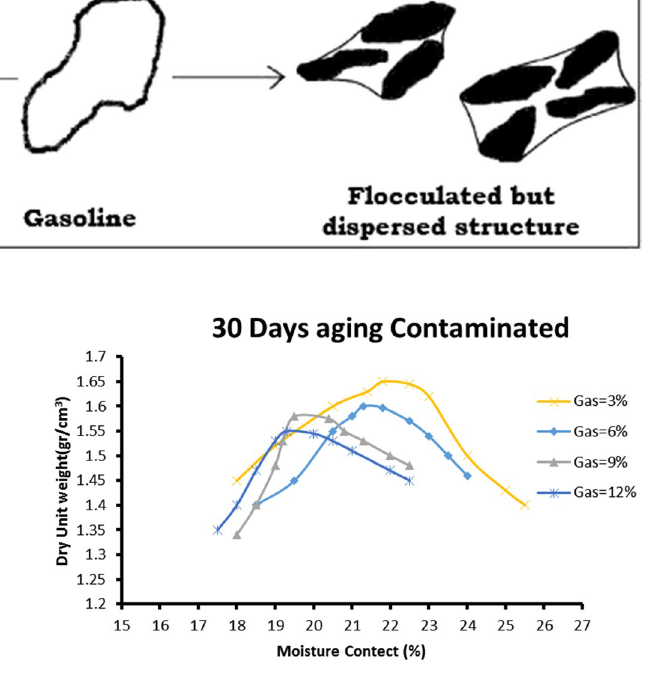
Fig. 10 Schematic of the gaso- line–particle interaction model